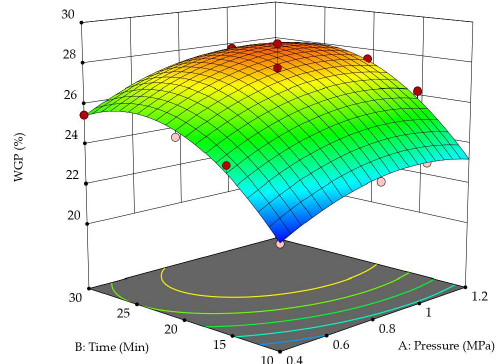
Figure 7. Three-dimensional surface and contour plot showing the effects of impregnation pressure and impregnation time on WGP .